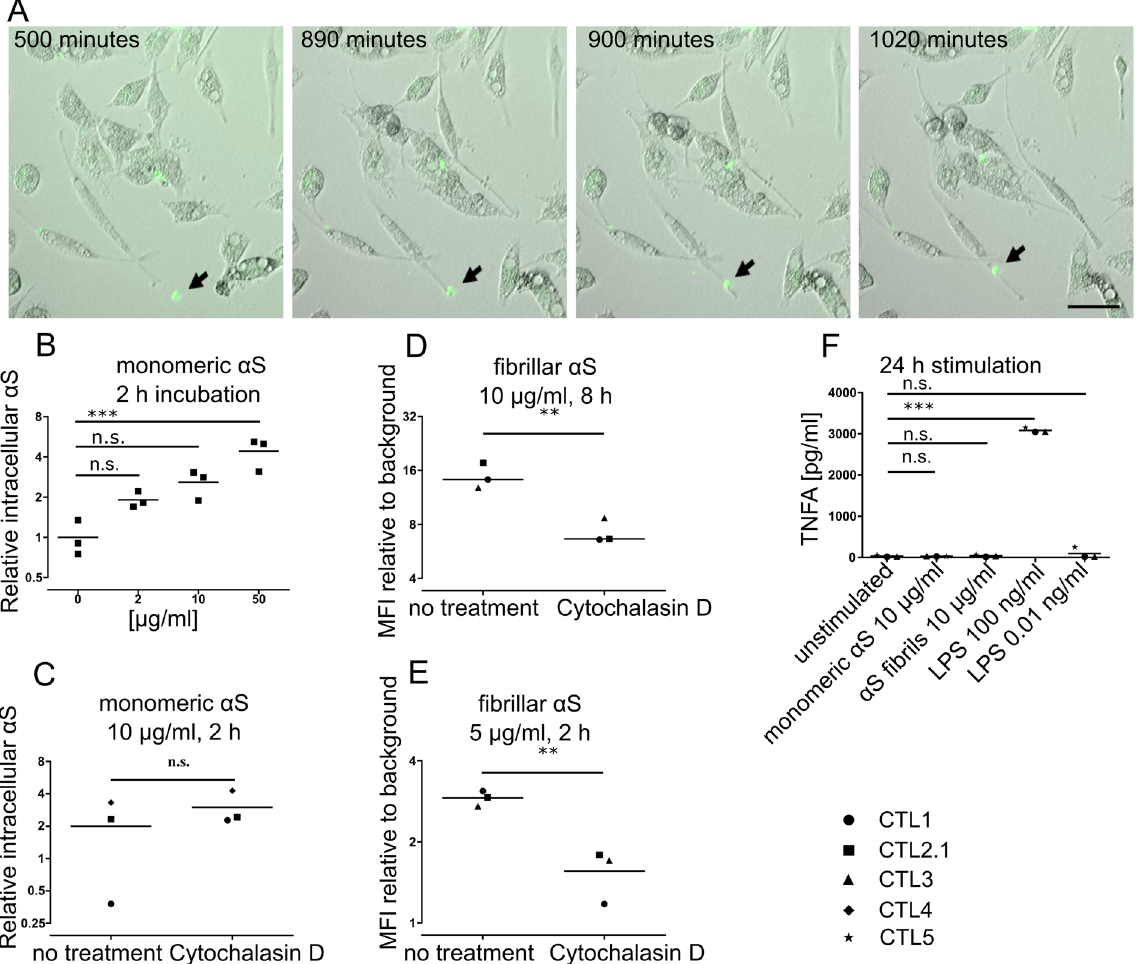
Figure 4. pMac take up fibrillar and monomeric α S. ( A ) 10 µ g/ml Oregon Green 488-labelled fibrillar α S was added to pMac (imaged every 5 mins, 18 hrs). Frames capture one selected phagocytosis event (scale bar = 50 µ m). ( B ) Intracellular α S levels following incubation with monomeric α S (FACs), normalized to mean endogenous α S levels in untreated pMac. ( C ) pMac incubated with monomeric α S, with or without Cytocholasin D (FACs as in ( B )). ( D ) pMac incubated with fluorescent α S fibrils, with and without Cytocholasin D (FACs), MFI fluorescent α S divided by MFI medium only. ( E ) as per ( D ) but lower dose and shorter time. ( F ) TNF α levels in pMac supernatants measured 24 hrs after monomeric or fibrillar α S or LPS. Statistical analyses: ( C , D , E ) two-tailed t-test; ( B , F ) one way ANOVA with Dunnett’s multiple comparisons test. Also see Figure